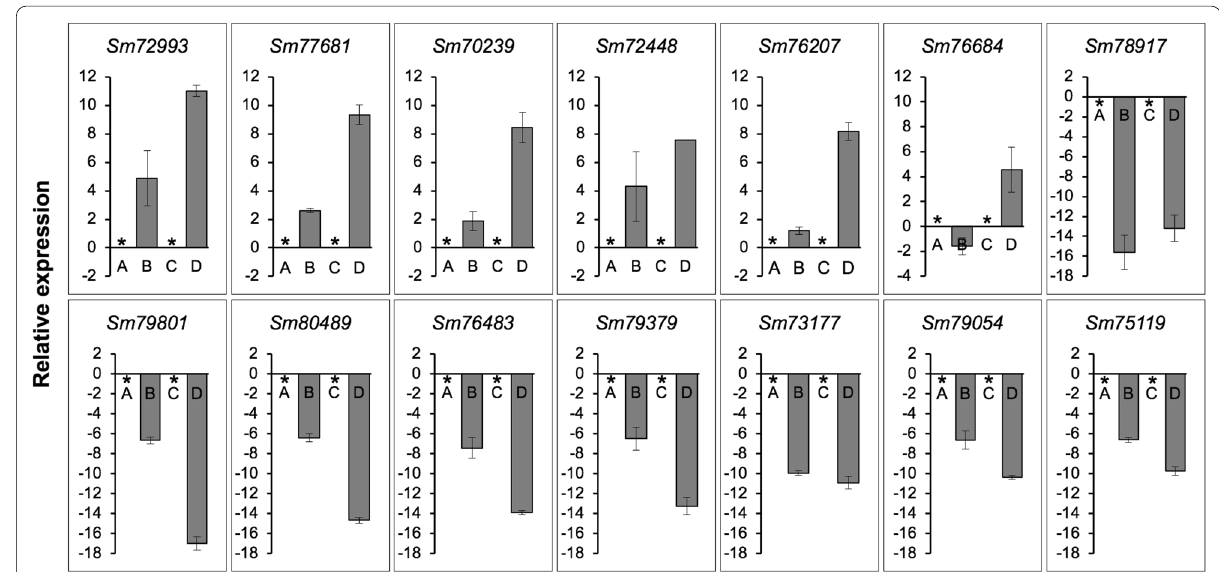
Fig. 4 Relative expression levels of 14 transcripts of S. mycoparasitica determined by quantitative real-time PCR. with/without the host F. graminearum at different incubation times (1.5 and 3.5 days) determined by quantitative real-time PCR. A, S.m. 1.5 days; B, S.m. 1.5 days interaction with F.g. 3-ADON; C, S.m. 3.5 days; D, S.m. 3.5 days interaction with F.g. 3-ADON. A and C are compared with B and D, respectively. The y -axis represents the log 2 fold change (A and C are zero indicated by the asterisk symbol). Error bars indicate the standard deviation of three replicates. The 18SrRNA was used as an internal control. Finally, the set of functional transcripts depicted Glucan 1,3-beta-glucosidase ( Sm72993 ); Tfo1: Ac-like transposon ( Sm77681 ); Glutathione synthetase ( Sm70239 ); Endochitinase B ( Sm72448 ); Filamentous hemagglutinin/adhesin ( Sm76207 ); ATP-binding cassette (ABC) transporter ( Sm76684 ); Uncharacterized mitochondrial protein ymf40 ( Sm78917 ); RNase H domain-containing protein ( Sm79801 ); Thioredoxin-2 ( Sm80489 ); Glutathione S -transferase omega-like 2 ( Sm76483 ); Thioredoxin reductase ( Sm79379 ); NADPH–cytochrome P450 reductase ( Sm73177 ); Uncharacterized protein ( Sm79054 ); Uncharacterized membrane protein YJL163C ( Sm75119